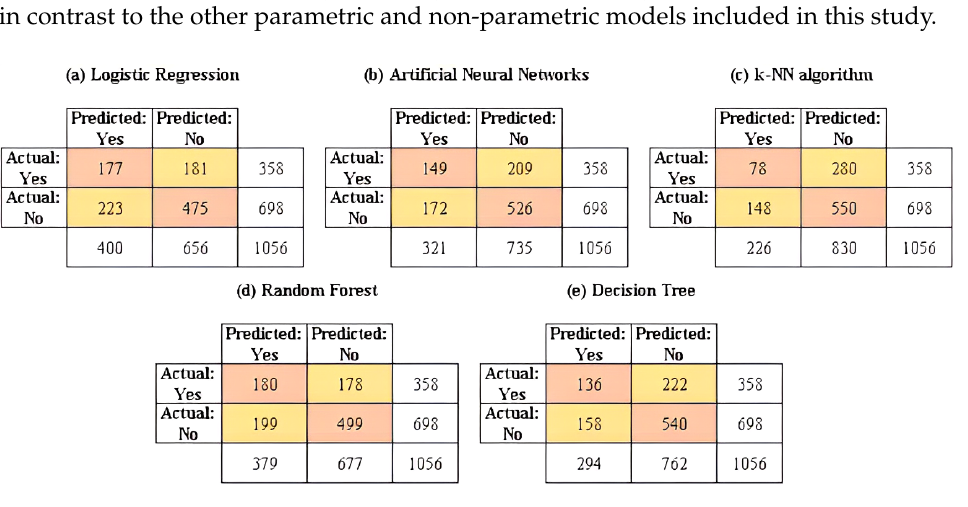
Figure 5. Confusion matrices for the machine learning models developed for the prediction of HIV/AIDS knowledge in the test set. Table 6. Performance metric comparison of parametric and non-parametric